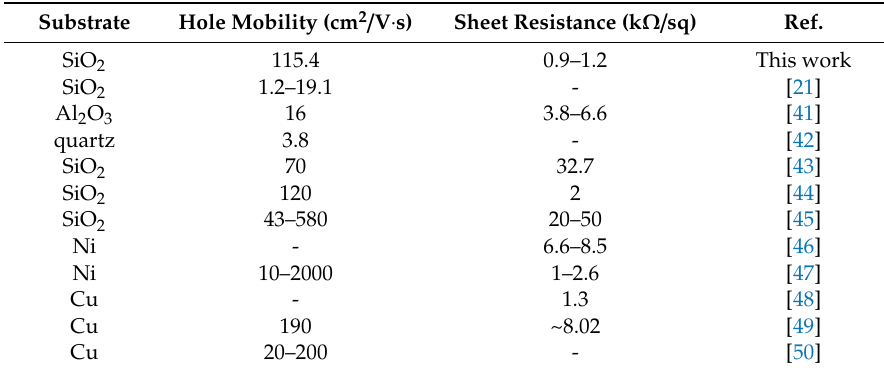
Figure 6. Electrical properties of the as-grown graphene. ( a ) Transfer characteristics (Ids–Vgs) of the field effect transistor (FET) device at Vds = 1 V. Inset is an image of the device configuration with 70 × 70 µm 2 . ( b ) Output characteristics (Ids–Vds) of the graphene device at various gate voltages. Table 1. Comparison of our results with the previous